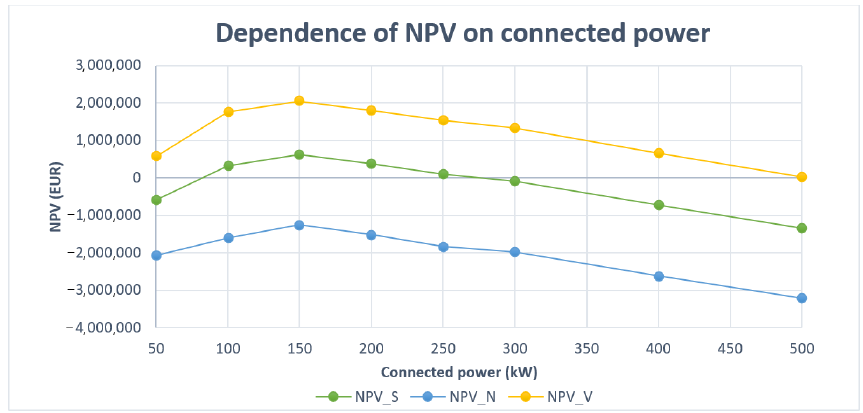
Figure 10. Dependence of NPV on the connected power of the small battery storage